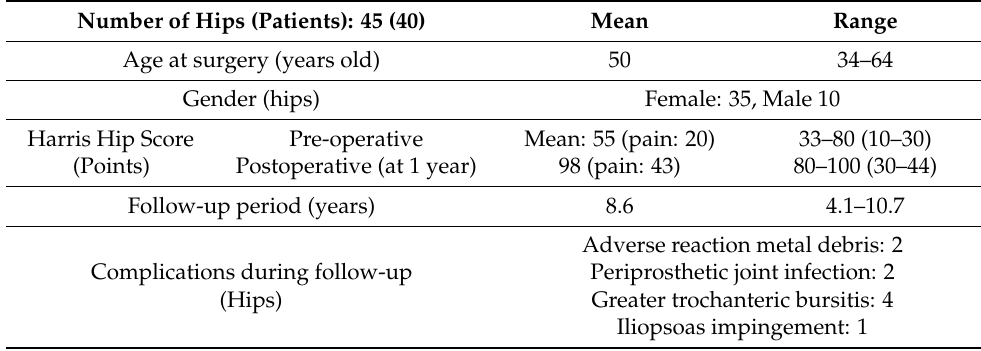
Table 1. Patient data before and after hip resurfacing